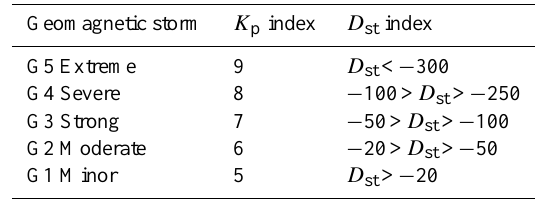
Table 7. Magnetic storm scale.